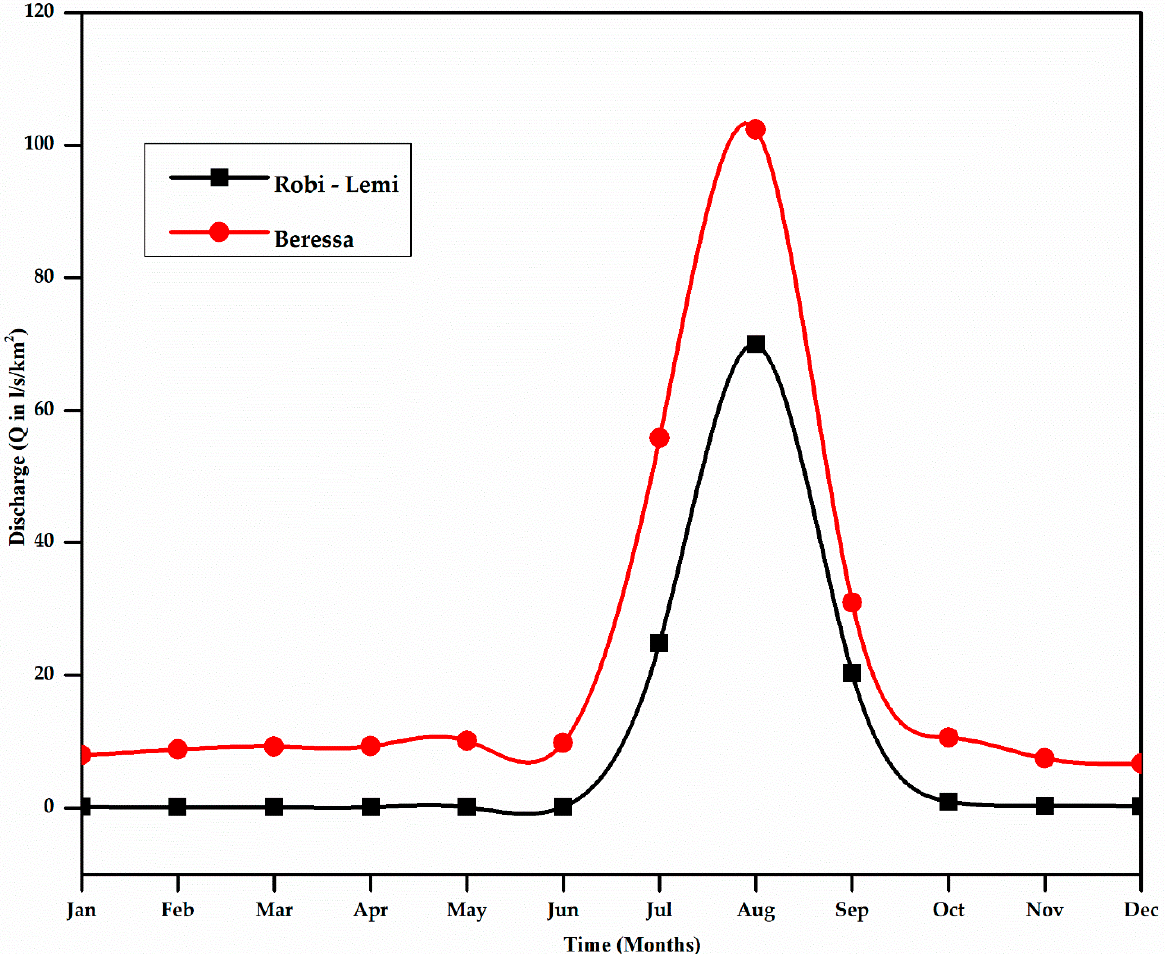
Figure 10. The mean monthly river discharge at Robi-Lemi and Beressa .